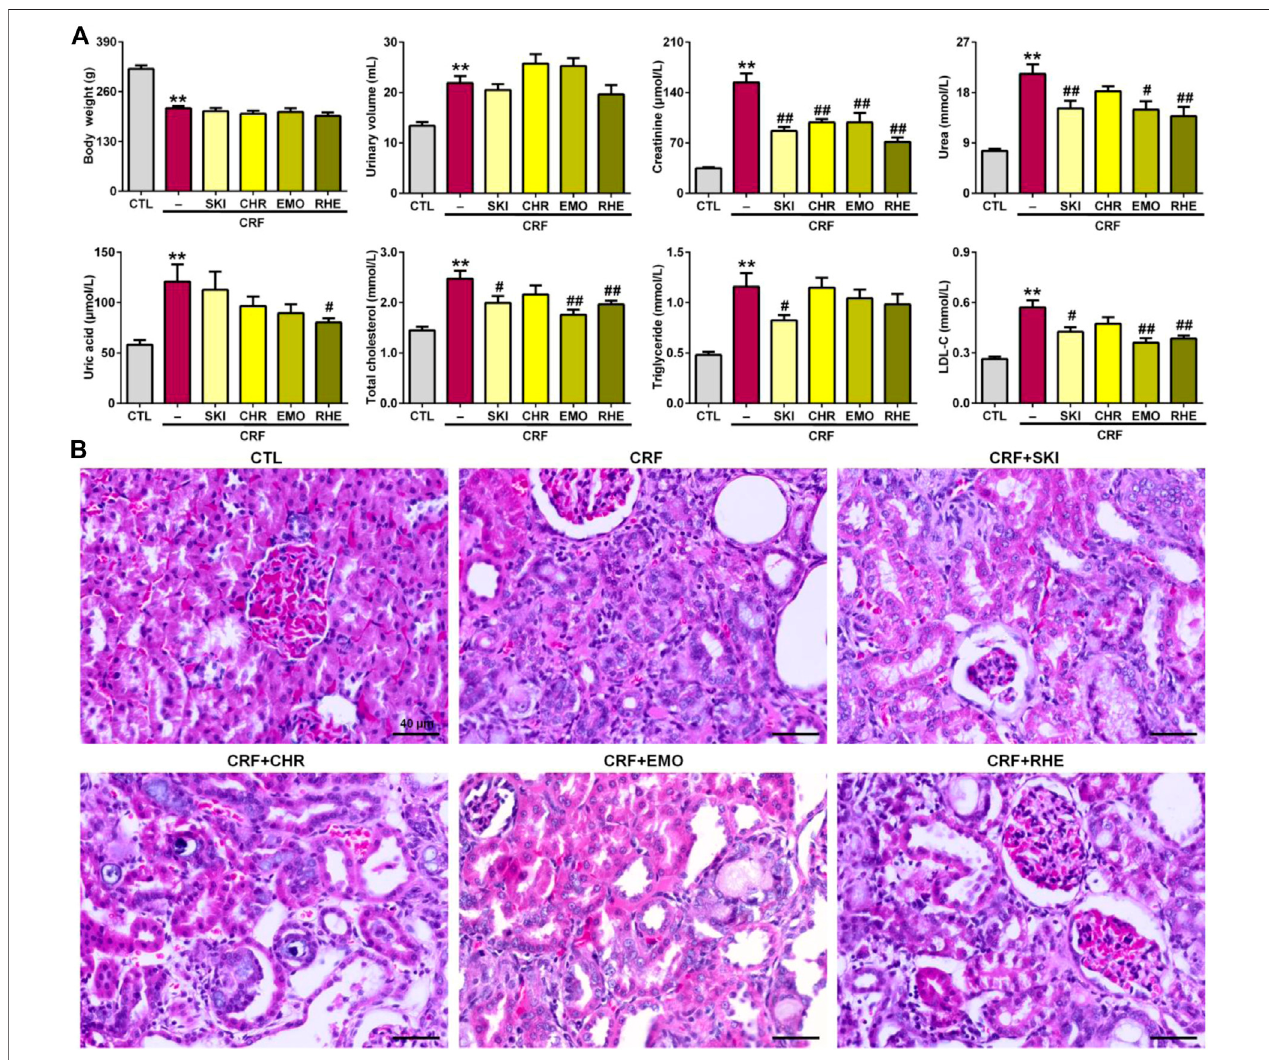
FIGURE1| SKIandthreeanthraquinonesincludingchrysophanol,emodin,andrheinimprovedrenalfunctionandinjuryintheadenine-inducedCRFrats. (A) Body weightandurinaryvolumeaswellasclinicalserumbiochemistryincludingcreatinine,urea,uricacid,totalcholesterol,triglyceride,andLDL-Cinthedifferentgroups.** p < 0.01 compared with the CTL group; # p < 0.05, ## p < 0.01 compared with the CRF group. (B) Images of H&E staining of the kidney tissues in the different groups. Scale bar, 40 μ